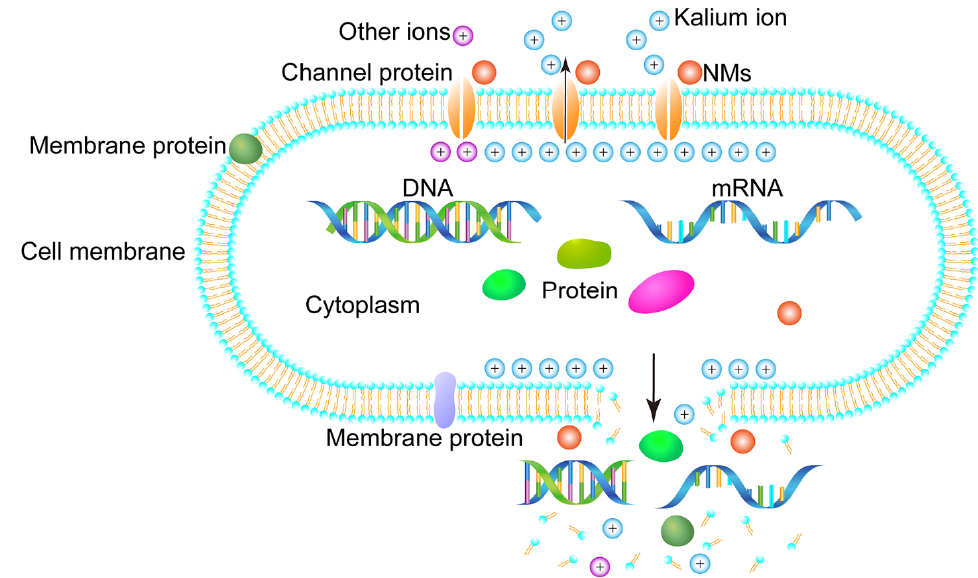
Figure 6. Schematic diagram of the antimicrobial activity mechanism of NMs. The interaction between NMs and the cell membrane changed the permeability and integrity of the cell membrane, leading to the loss of intracellular ions, proteins, nucleic acids, and other substances and accelerating the cell death. The growth curve reflected the growth-inhibition effect of the microemulsion on bacteria and fungi from a macroscopic perspective. The relative conductivity, protein leakage, and nucleic acid leakage reflected